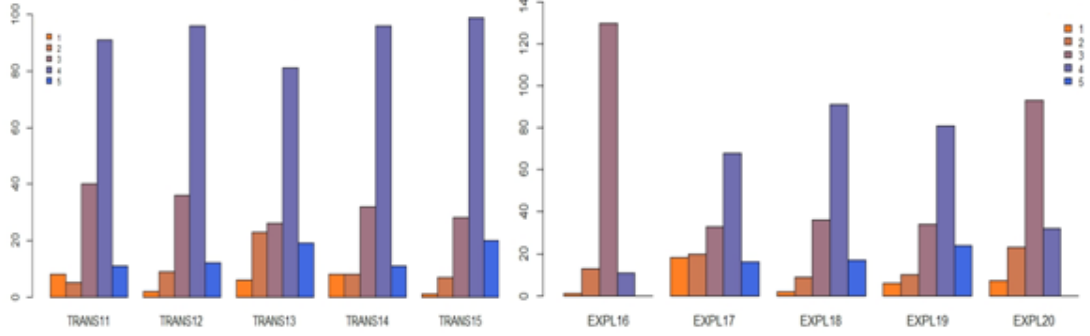
Figure 2. Questions that corresponds to transformation and exploitation variables in innovative